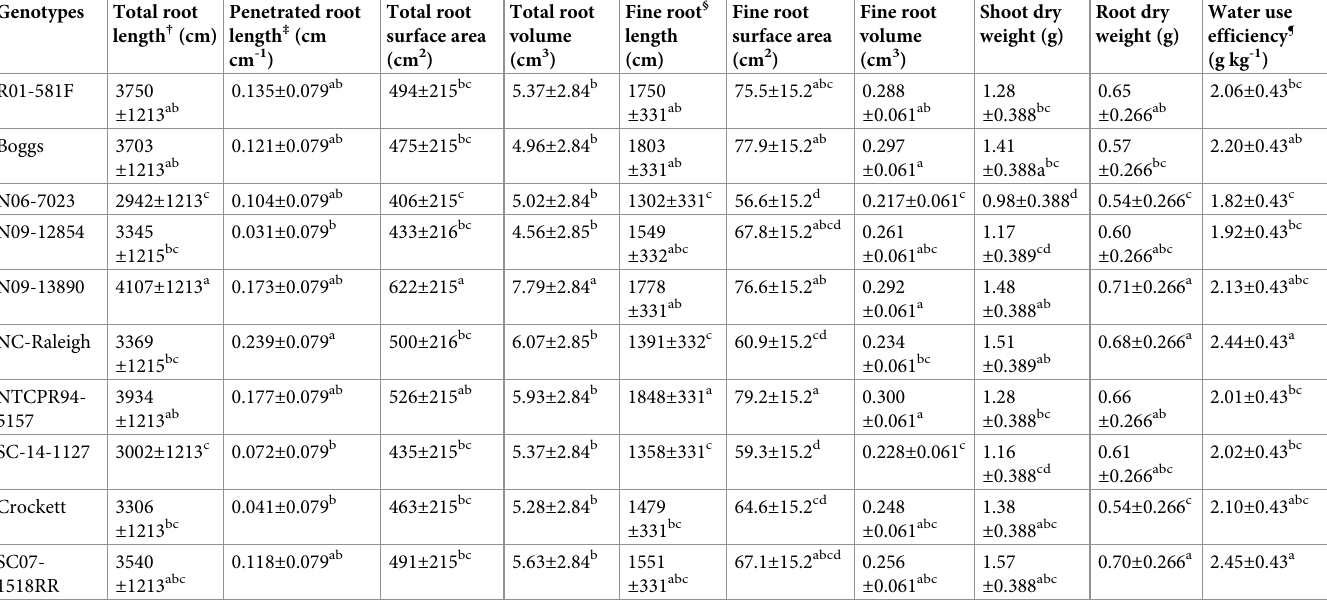
Values shown are least square means ± standard errors. Least square means with different letters are significantly different according to the LSD test at P < 0.05. † Sum of the lengths of all roots above and below the hardpan. ‡ Ratio between length of the roots below the hardpan and the total length of the roots below and above the hardpan § Diameter < 0.25 mm ¶ Ratio between the amount of aboveground biomass produced and water used during a 40-day growth period.